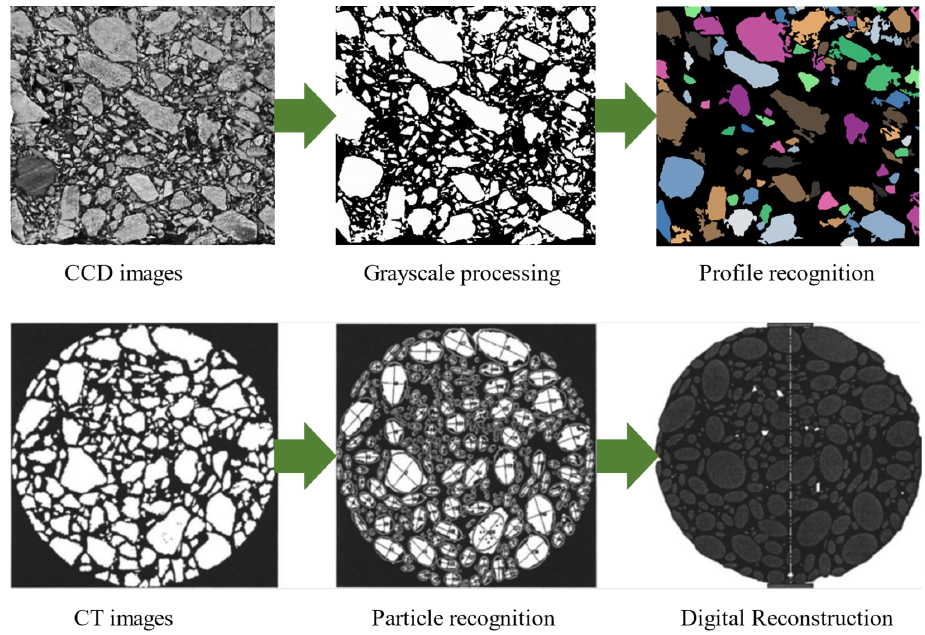
Figure 6. Schematic diagram of 2D aggregate particle identification.